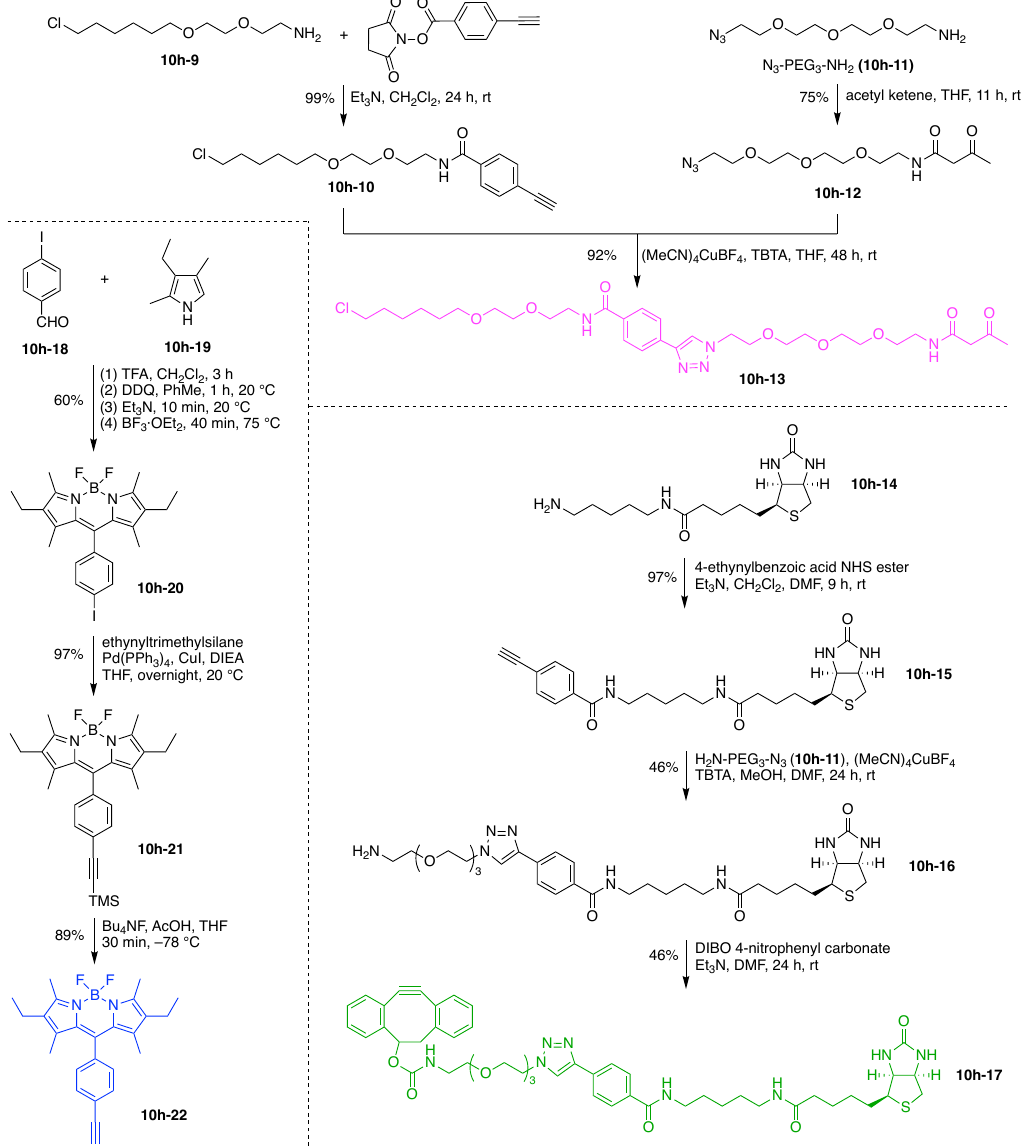
Three subunits for 1,2,3-triazole formation were then synthesized following the routes in Figure 46. The chloro-amine 10h-9 underwent amidation with the NHS ester of 4-ethynylbenzoic acid to give 10h-10 . The azido-PEG-amine 10h-11 was reacted with acetyl ketene to give PEG- azide 10h-12 . The Cu-catalyzed click reaction between ethyne 10h-10 and PEG-azide 10h-12 in the presence of tris[(1-benzyl-1 H -1,2,3-triazole-4-yl)methyl]amine (TBTA) gave the β -ketoamide- type HaloTag ligand 10h-13 . In parallel, 5-((+)-biotinamido)pentylamine 10h-14 was reacted with the NHS ester of 4-ethynylbenzoic acid to give 10h-15 , which upon click chemistry with azido-PEG-amine 10h-11 again in the presence of TBTA gave amino-biotin 10h-16 . Reaction of the latter with the 4-nitrophenyl carbonate of the strained dibenzocyclooctyne (5,6-didehydro- 11,12-dihydrodibenzo[a,e]cyclooctene, DIBO) gave cyclooctyne derivative 10h-17 . In addition, in parallel, p -iodobenzaldehyde ( 10h-18 ) and 3-ethyl-2,4-dimethylpyrrole ( 10h-19 ) were converted via a four-step protocol [259] to the corresponding BODIPY 10h-20 , which upon Sonogashira coupling with trimethylsilylethyne gave 10h-21 [260]. Standard cleavage of the trimethylsilyl (TMS) group with tetrabutylammonium fluoride (TBAF) gave the ethynyl-substituted BODIPY Organics 2021 , 2 , FOR PEER REVIEW 10h-22 [260]. O ONO